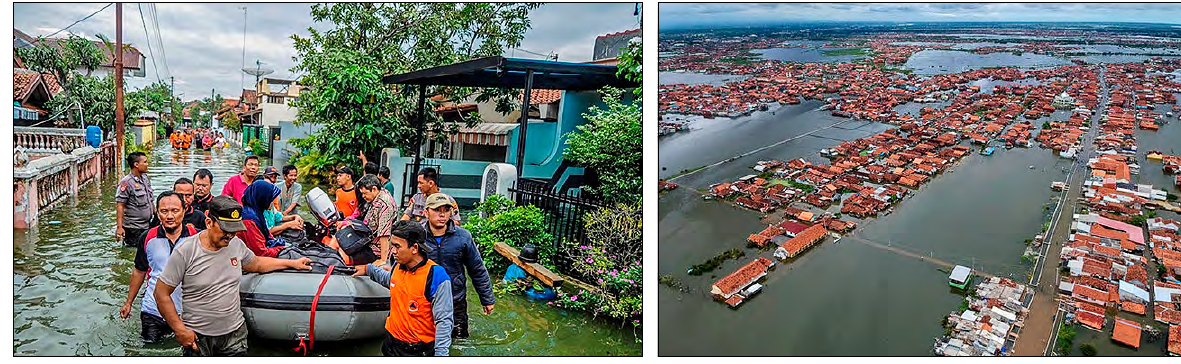
Figure 1. Flood Conditions on the Coast of Pekalongan Coast